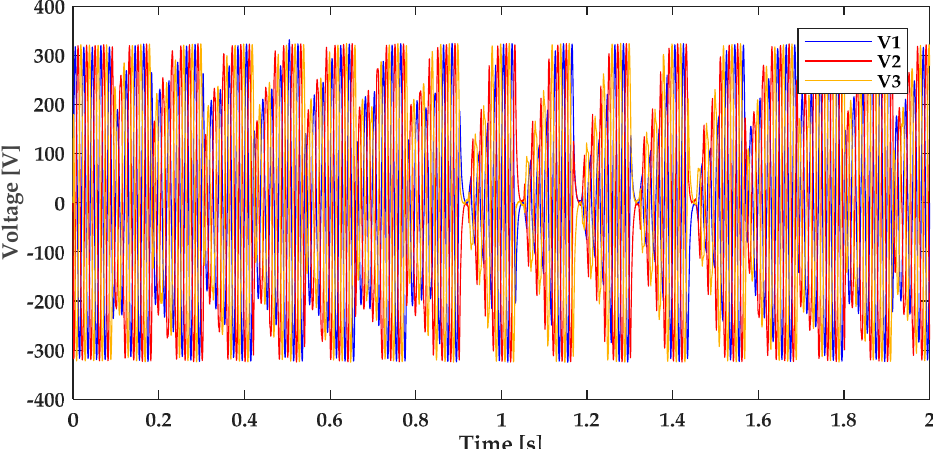
Figure 19. Voltage variation on SST AC connection in the unstable situation of “low inertia capacitor”